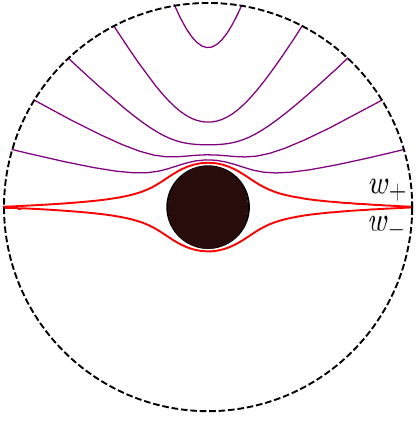
Figure 8 . Direct equal-time geodesics in the upper half of the initial time